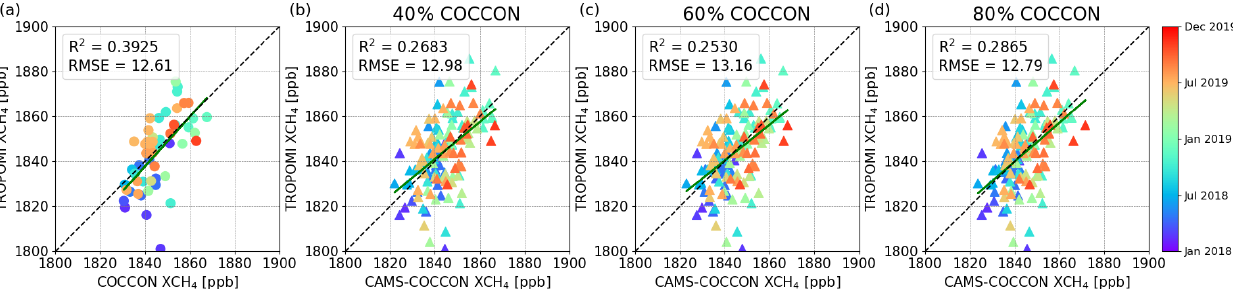
Figure A11. Correlation plots of (a) COCCON and (b–d) CAMS-COCCON with respect to TROPOMI XCH 4 at Karlsruhe. The CAMS- COCCON datasets are based on 40%, 60% and 80% of COCCON measurement days. Table A3. The variability (standard deviation) of the original CAMS products during the COCCON measurement period in each city and bias and standard deviation for the difference between CAMS and COCCON, as well as between scaled CAMS and COCCON. Species Variability CAMS–COCCON Scaled Variability CAMS–COCCON